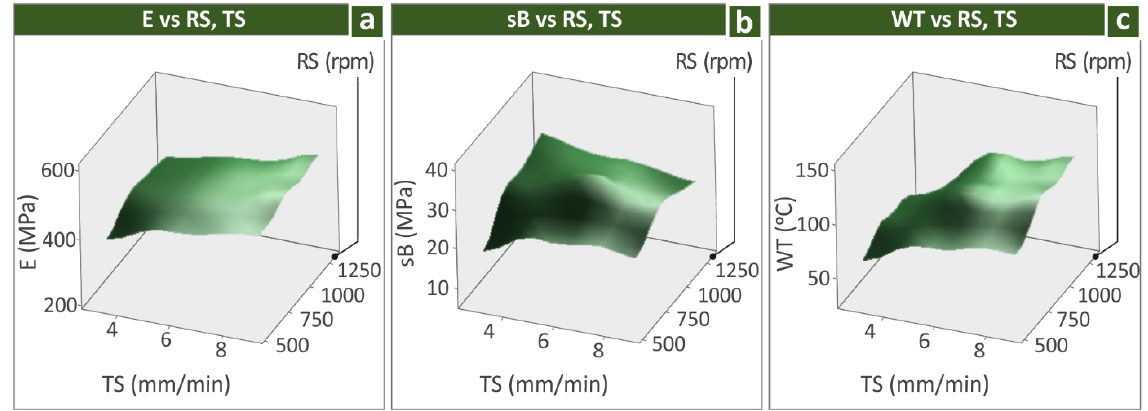
Figure 15. Surfaces of processing parameters vs.: ( a ) E, ( b ) sB, and ( c ) WT. After the above analysis utilizing descriptive statistical tools (MEP plots, interaction charts, and surfaces plots), quadratic regression models were adopted for all outputs in the